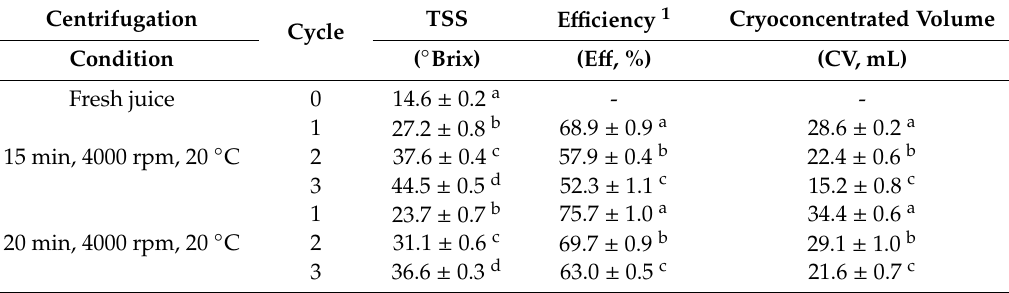
Table 1. Preliminary results obtained at di ff erent centrifugation